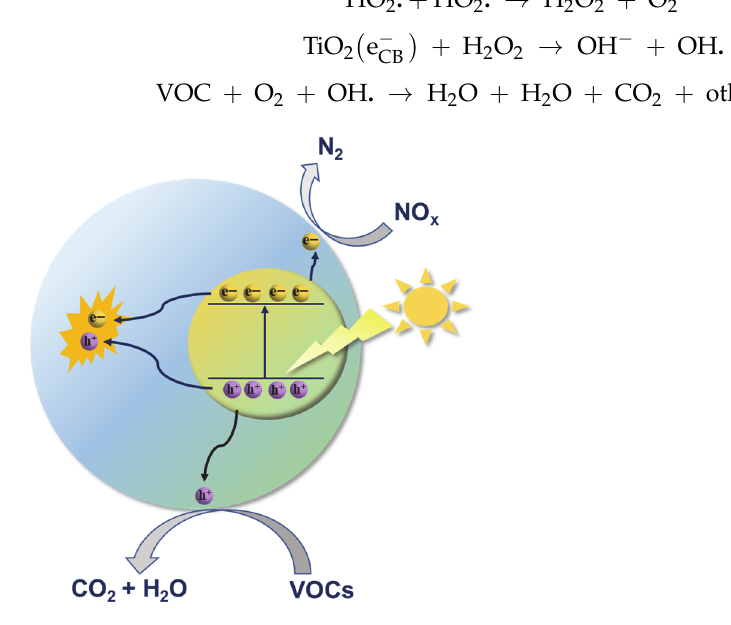
Figure 1. Schematic diagram of the mechanism of vehicle exhaust elimination by photocatalysis.